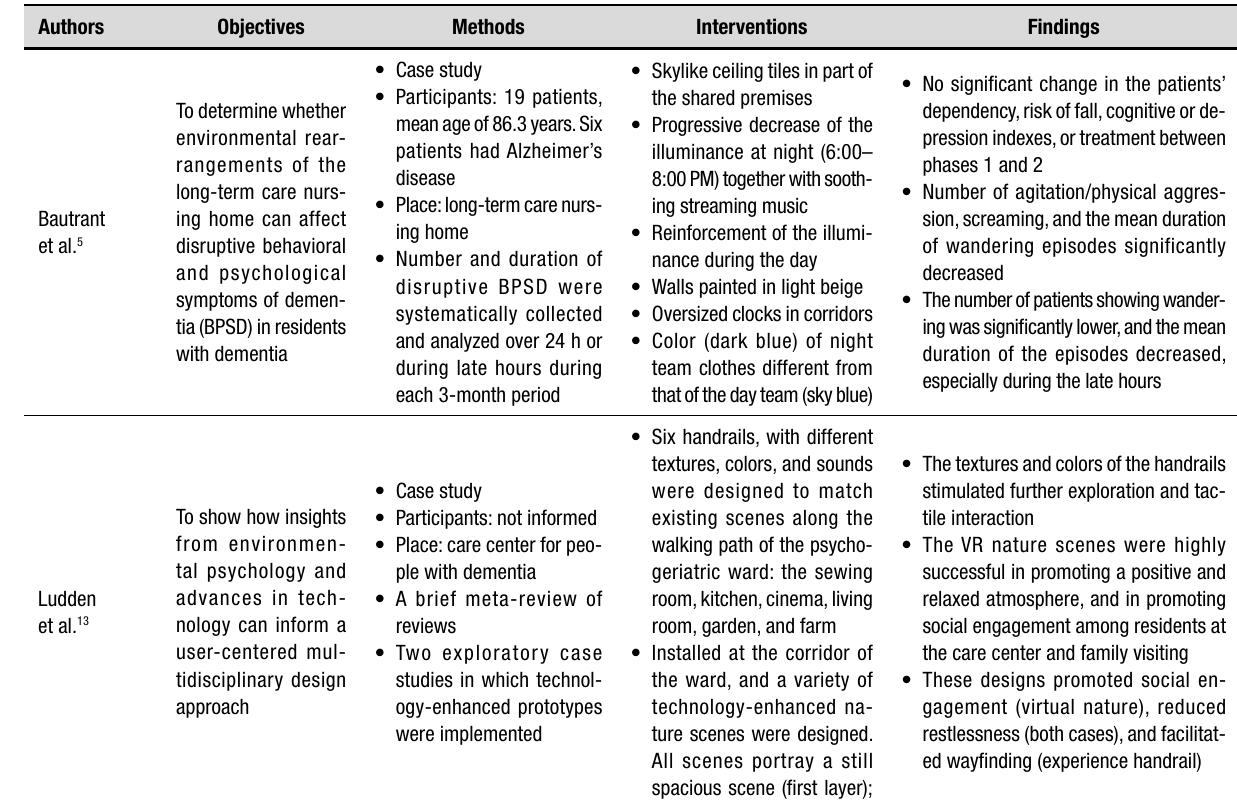
Table 2. Articles’ main objectives, methods, interventions, and their